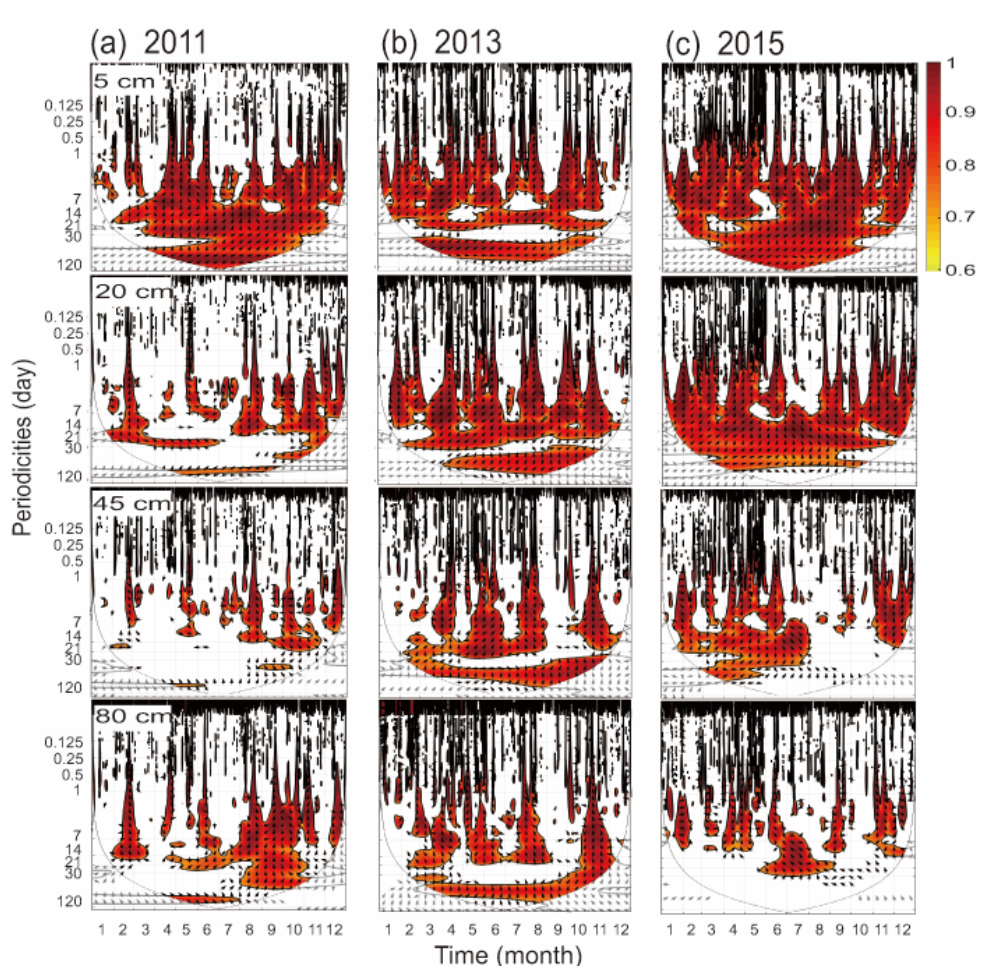
Figure 3. The wavelet coherence between precipitation and soil moisture content in grassland at different depths (i.e., 5, 20, 45, and 80 cm) in ( a ) a drought year (2011), ( b ) a normal year (2013), and ( c ) a pluvial year (2015). Wavelet coherence is indicated by a color scale ranging from 0–1 with the value of 1 (the darkest red-brown) indicating the greatest coherence. To highlight the energy change of the time-series at a small scale, the vertical axis of the wavelet coherence has a logarithmic axis, and the abscissa axis is linear. The arrow pointing right indicates that the precipitation and soil moisture content is in phase; oppositely, the soil water and precipitation are out of phase. Only the areas which are pointwise significant at the 5% level and fall outside the cone of influence (COI) are colored.